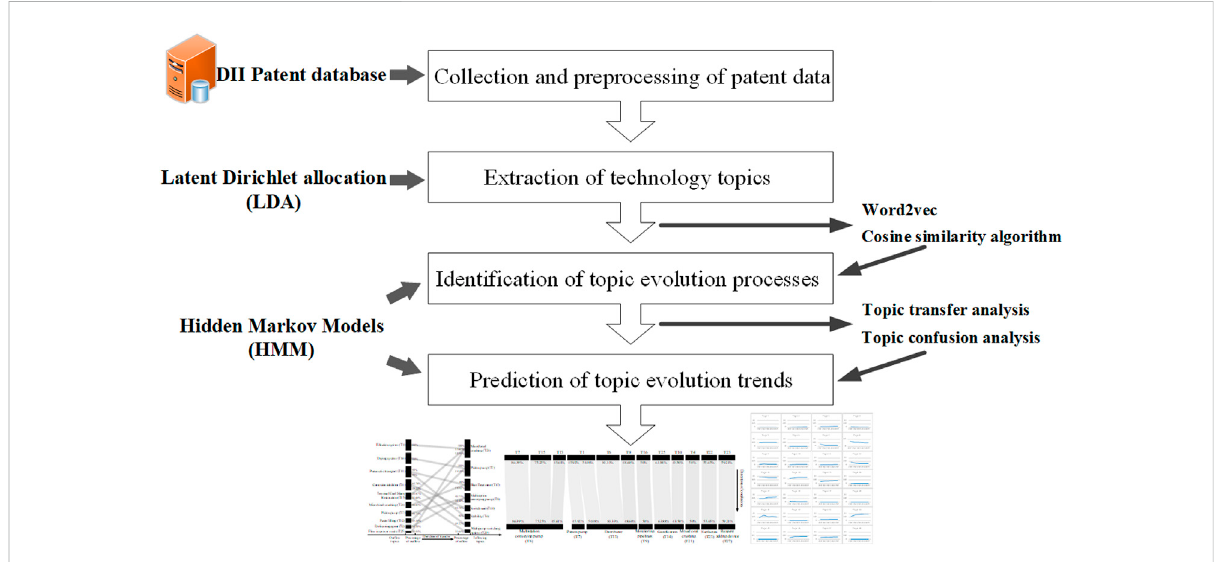
FIGURE 1 Framework for analyzing and forecasting technology